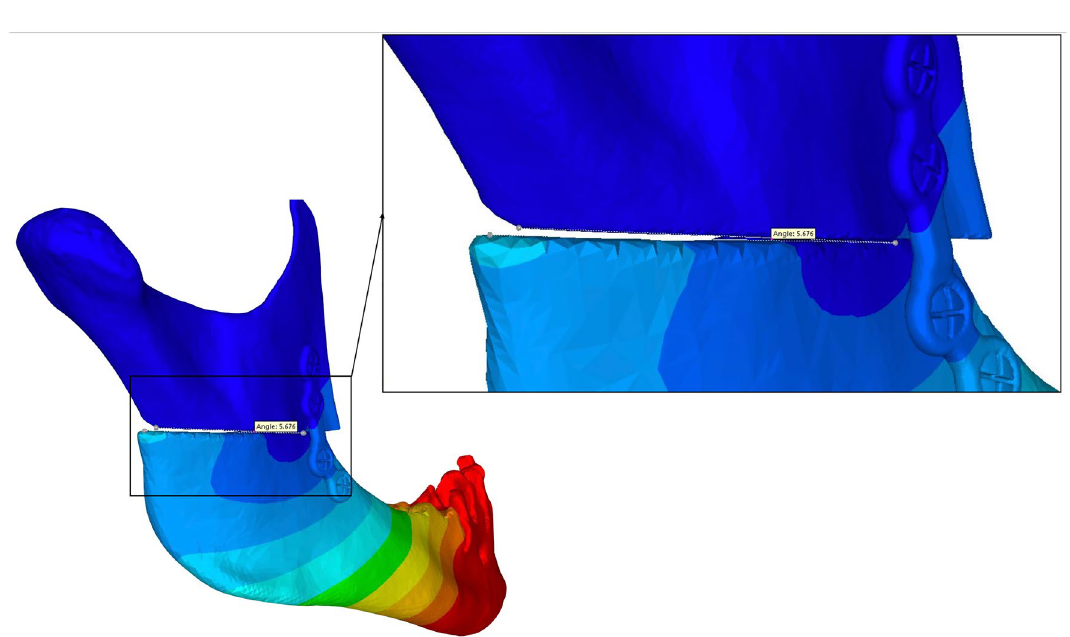
Figure 9. A gap with a 5° angle in the posterior area in the T2-A1 model shows a large displacement shift between the proximal and distal segment, compromising